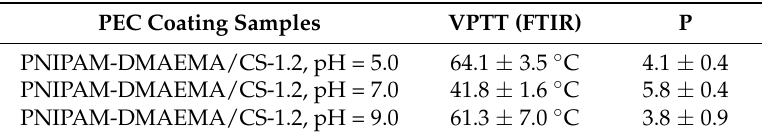
Table 5. VPTT and P values found by fitting the courses of Amide II from ATR-FTIR spectra of